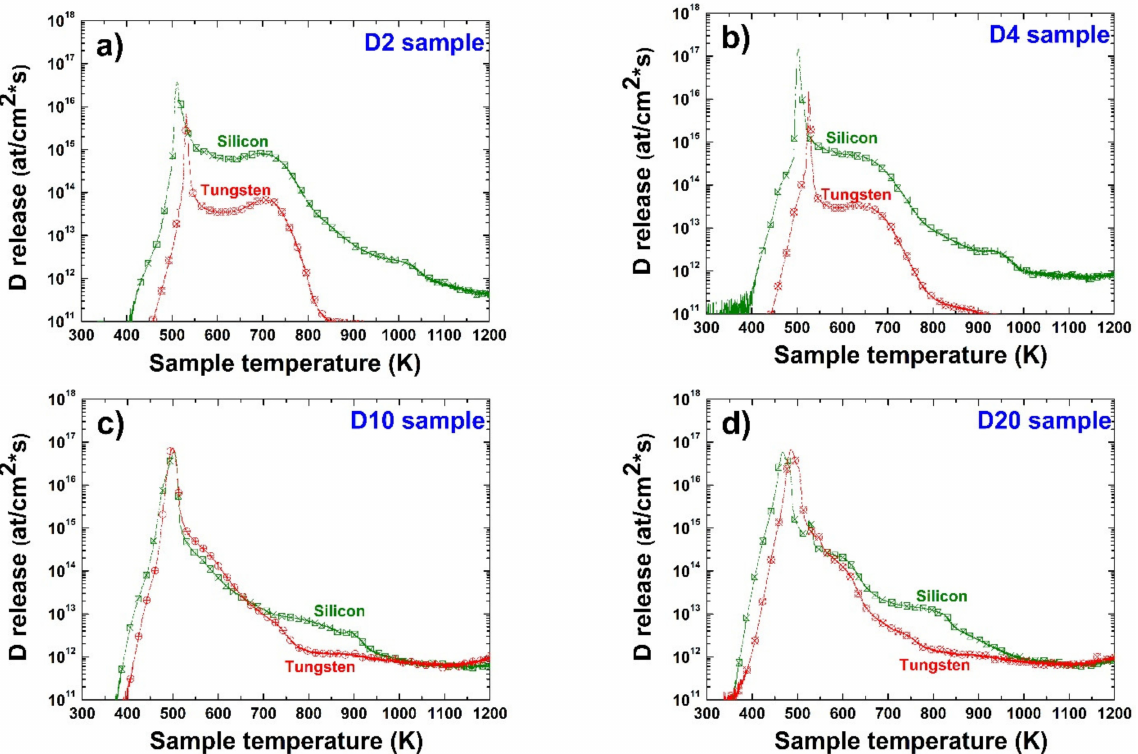
Figure 5. Deuterium release comparison for the Be-D layers deposited on tungsten and silicon substrates: ( a ) D2; ( b ) D4; ( c ) D10; ( d )